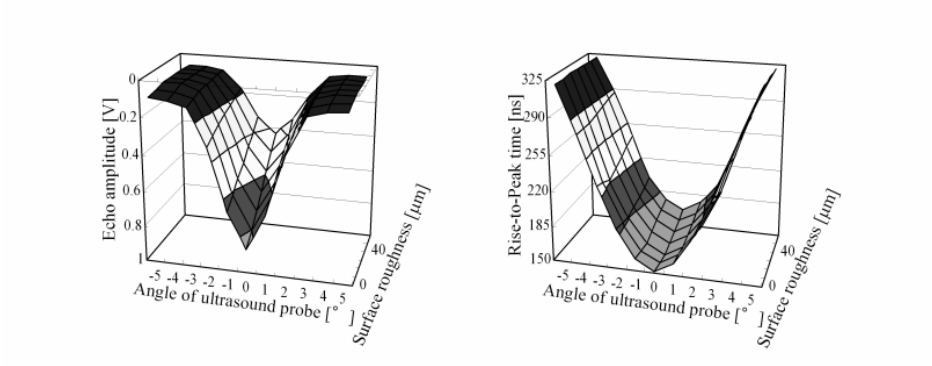
Figure 7: The effects of the probe angle and surface roughness on the echo amplitude and the Rise-to-Peak time. (a): Echo amplitude. (b): Rise-to-Peak